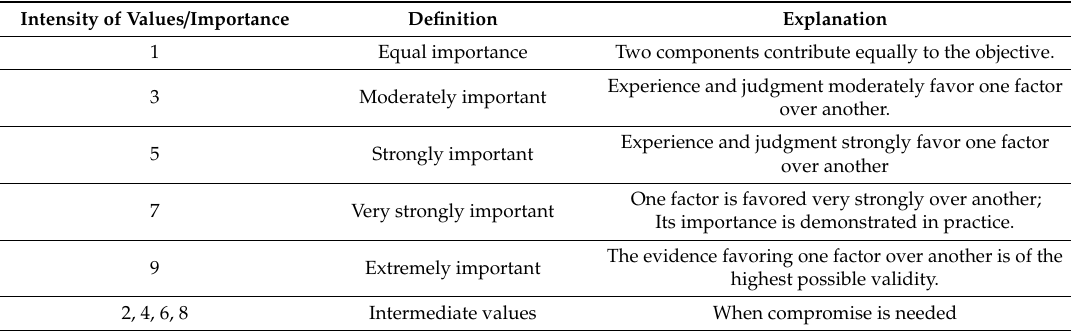
Table 4. Importance values, used in the analytic hierarchy process (AHP) rankings based on [40].